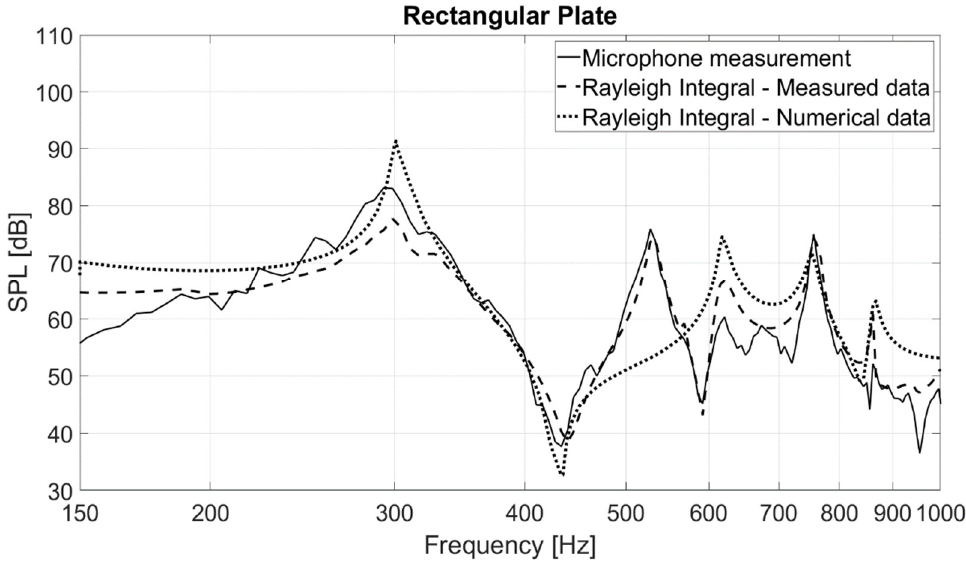
Figure 10. SPL recorded by microphone (solid line) superimposed with SPL calculated by Rayleigh’s integral (dash line).